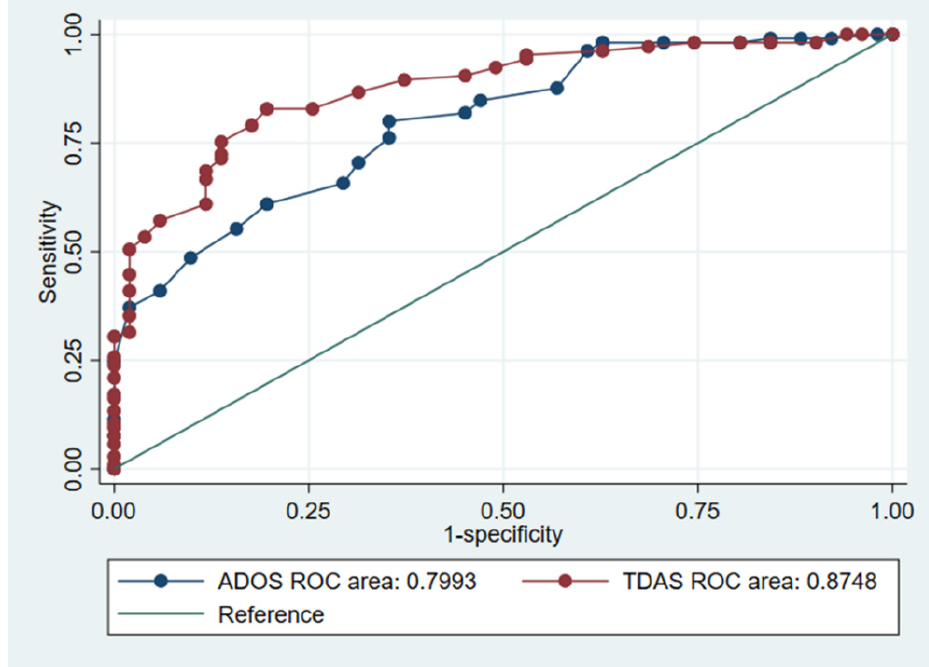
Figure 1. ROC curves for the ADOS-2 and TDAS scores according to the DSM-5 ASD criteria.